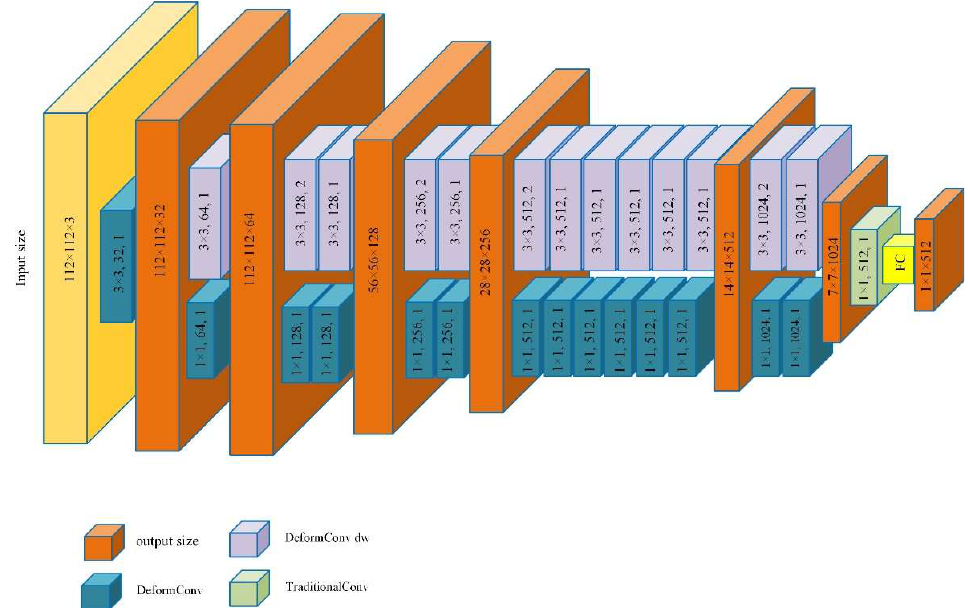
Figure 10. The network architecture is used for the recognition network. Each intermediate tensor is labeled filter size, channels and stride. Activation layers and batch normalization layers are inserted after each convolution but are not pictured here.